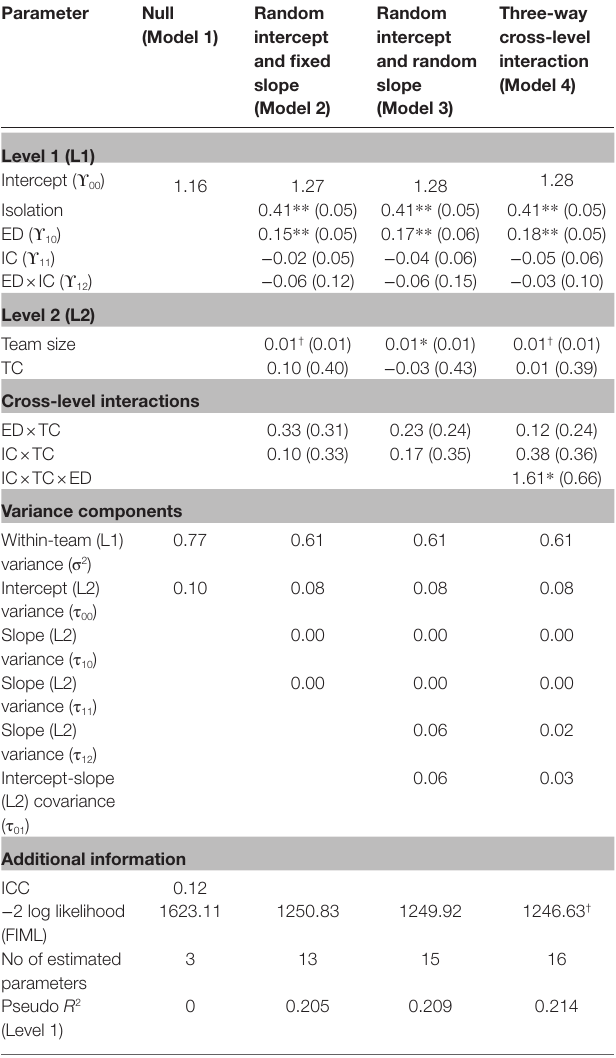
TABLE 2 | Regression coefficients from multilevel regression predicting burnout from exposure to danger (ED), individual-level coping (IC), and team-level coping